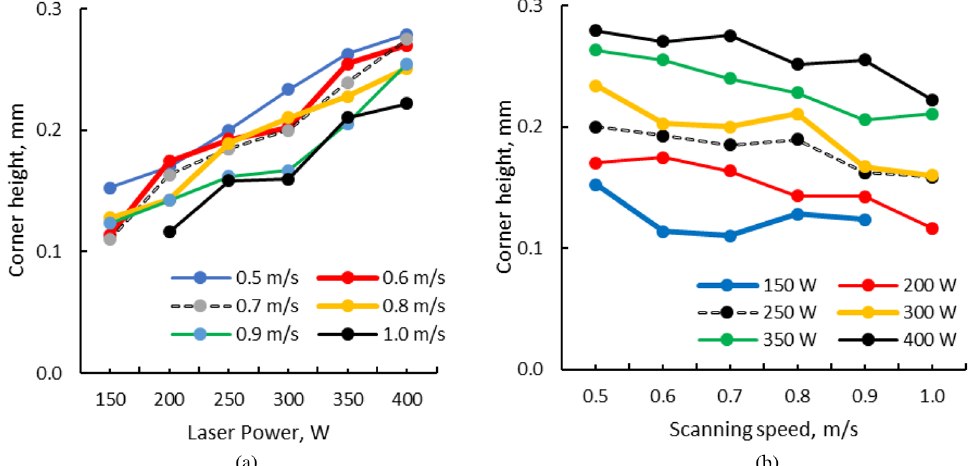
Fig. 9. Corner height as a function of laser power (a) and scanning speed (b).